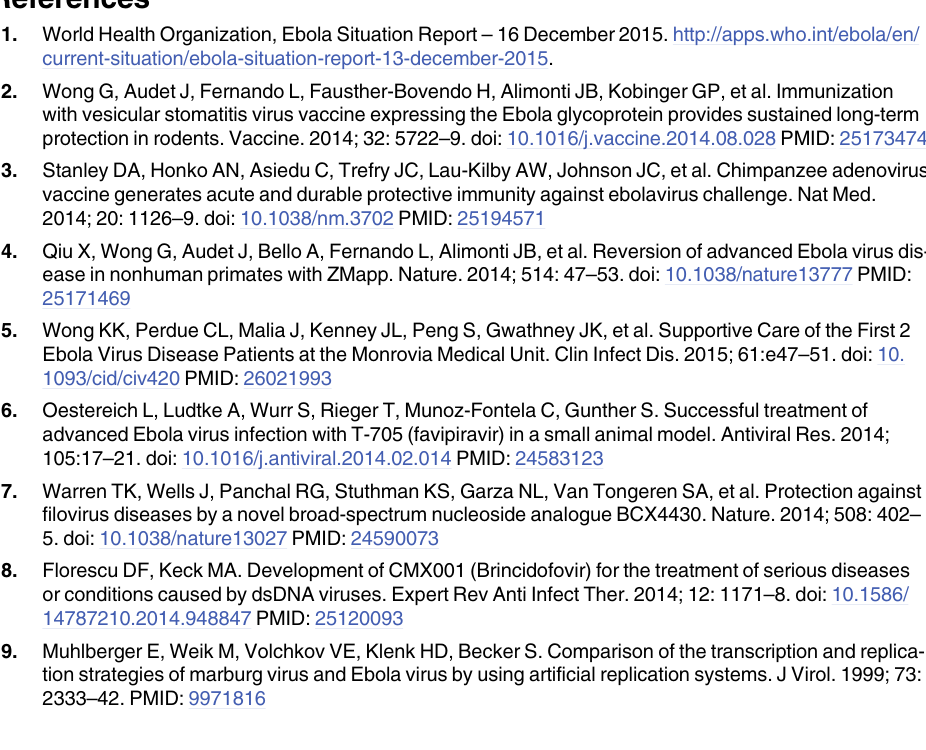
S1 Table. Fi and CI values for two-drug combination treatments. Experimental details are as described in the legend to Fig 4. The fractional inhibition, combination index and strength of synergy (+), additive effects (+/-) or sub-additive (-) of each 2 drug combination therapy are shown. S2 Table. Fi and CI values for three-drug combination treatments. Experimental details are as described in the legend to Fig 4. The fractional inhibition, combination index and strength of synergy (+), additive effects (+/-) or sub-additive (-) of each 3 drug combination therapy are